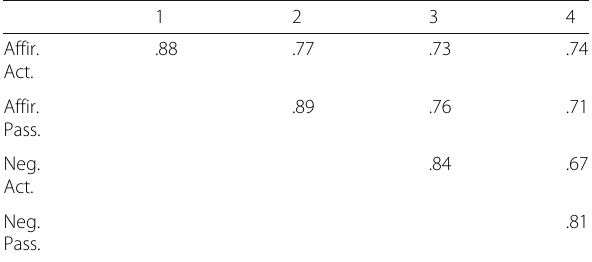
Table 3 Correlations between the subtests of PAGRT and their CFA factor loadings